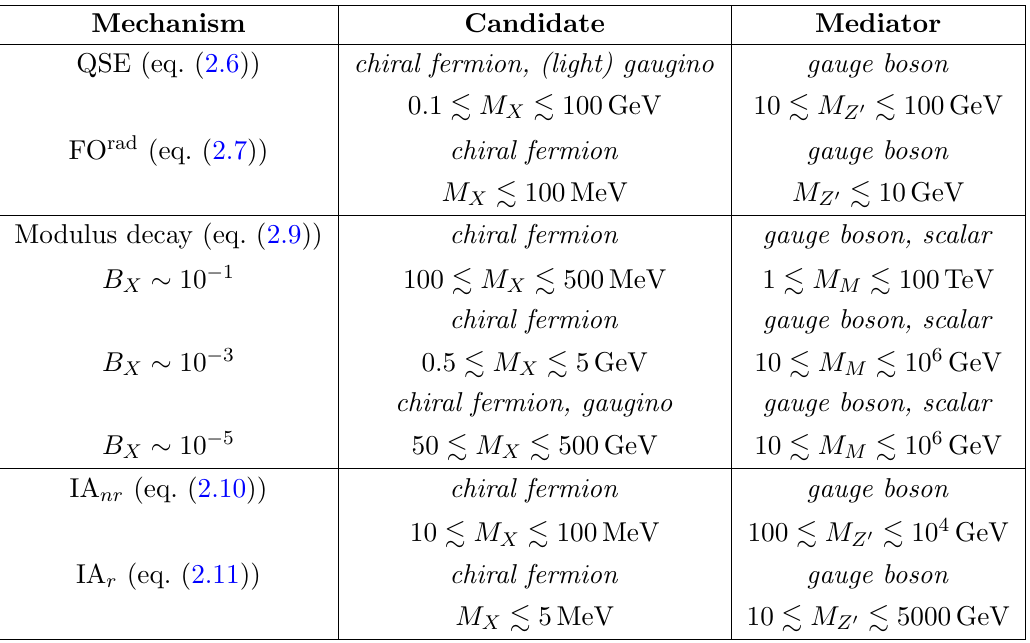
Table 1. Table summarising the various relic density production mechanisms, with suggested dark matter and messenger candidate